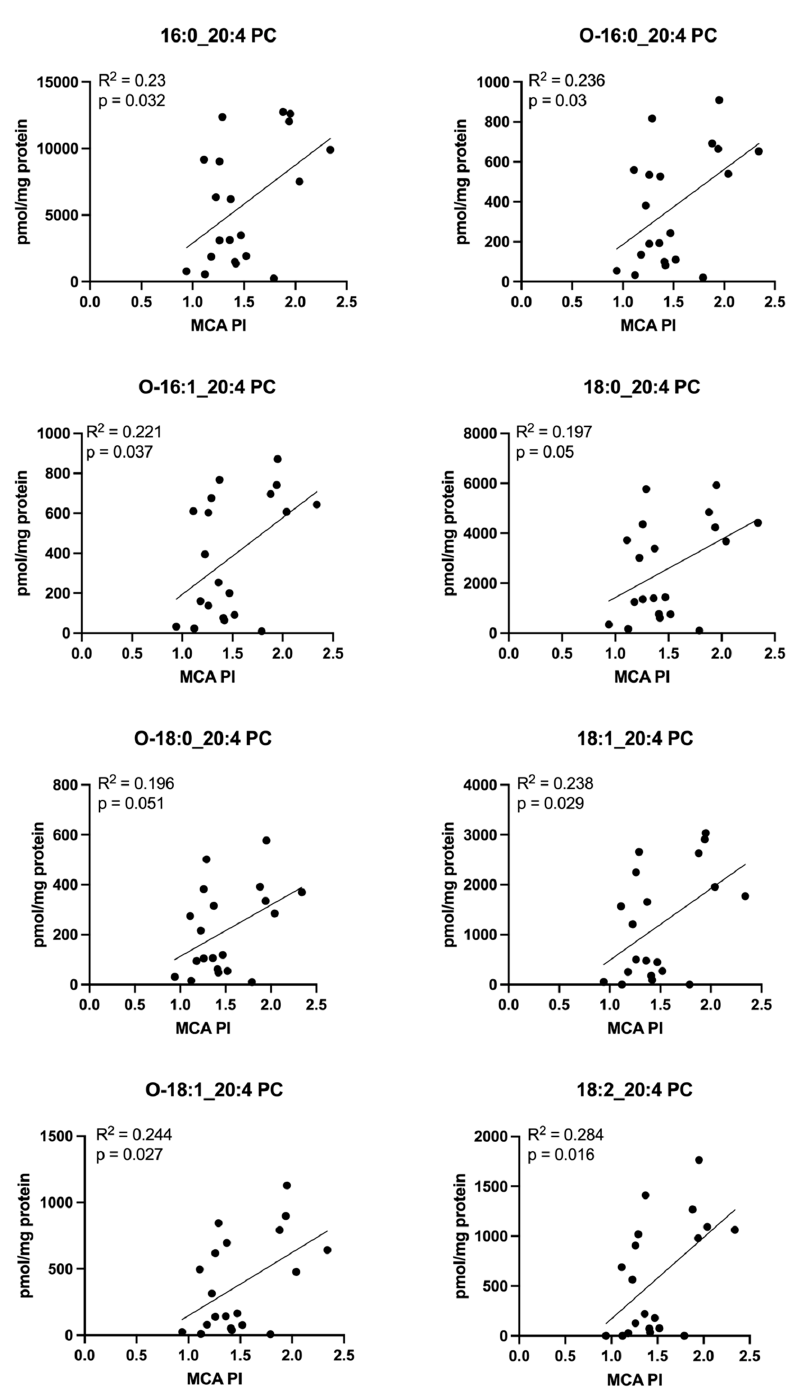
Figure 12. Correlations between MCA PI and concentrations of phosphatidylcholine molecules containing arachidonic acid (20:4) in the placenta. Scatterplots demonstrate direct correlation between middle cerebral artery pulsatility index (MCA PI) and placental concentrations of multiple phos- phatidylcholine (PC) molecules containing arachidonic acid (20:4). “O-” denotes an ether linkage. Pearson correlation coefficient was computed to assess relationships.